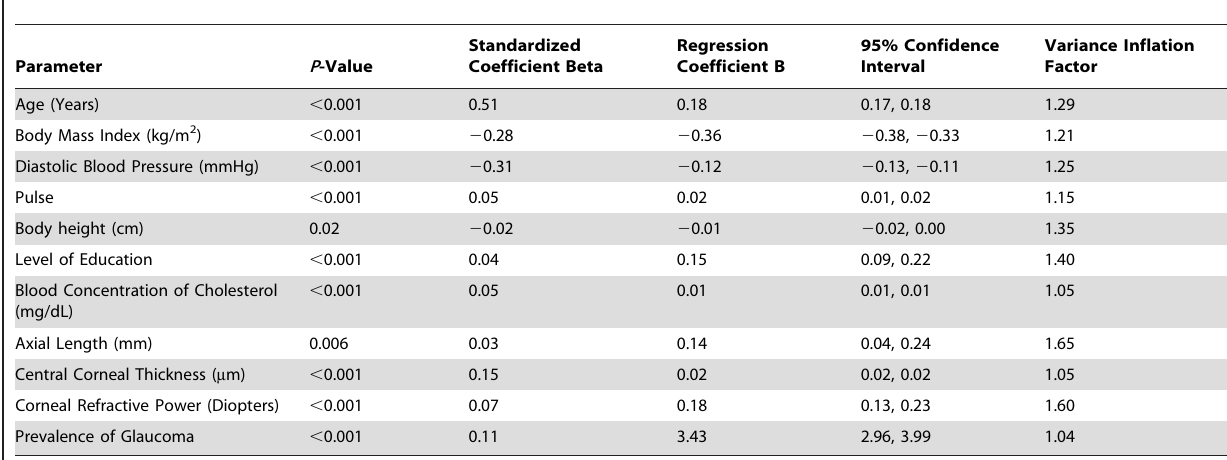
Table 1. Results of the multivariate analysis of the association between the calculated trans-lamina cribrosa pressure difference and ocular and systemic parameters in the non-glaucomatous population of the Central India Eye and Medical